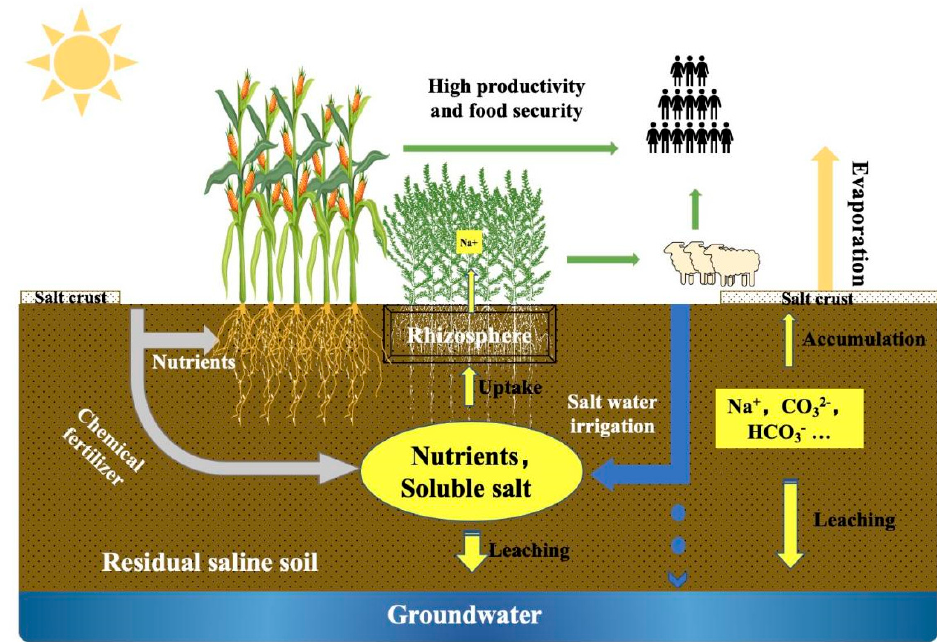
Figure 3. Agricultural developing model in the saline–alkali lands of northwest China.